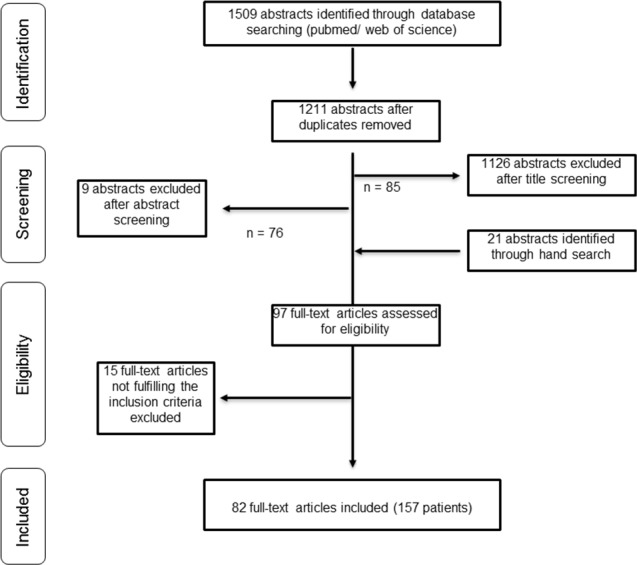
Procedure of publication retrieval and in- and exclusion of cases displayed in a PRISMA (Preferred Reporting Items for Systematic Reviews and Meta-Analyses) flow chart (4).